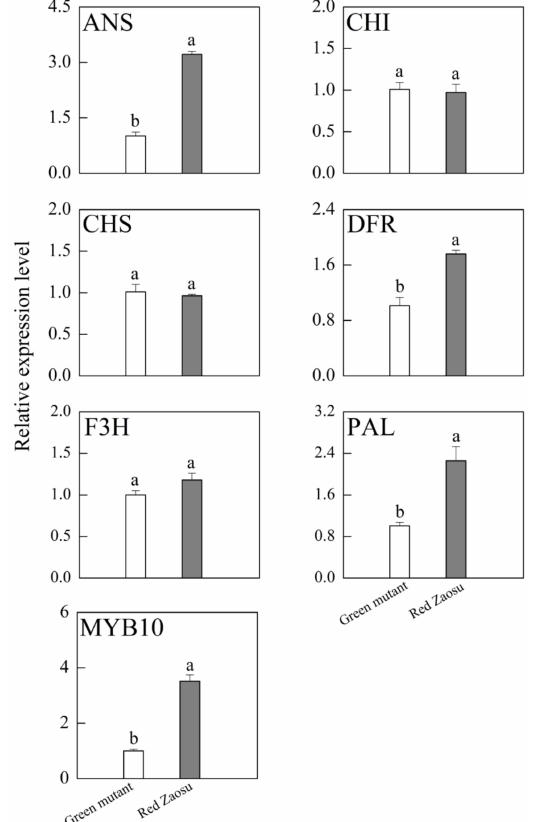
Figure 7. Expression patterns of the anthocyanin biosynthetic genes and MYB10 in ‘Red Zaosu’ and its green mutant. Different lowercase letters indicate significant differences by ANOVA and Duncan's test at p <